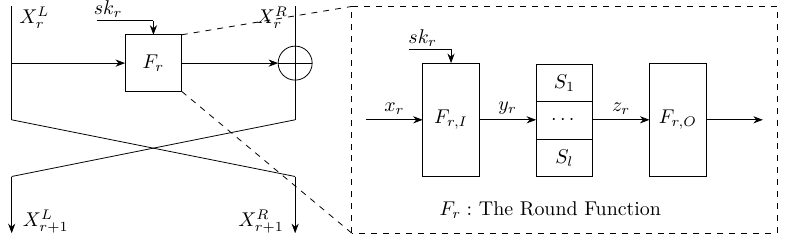
Figure 1: Generalized round of a Feistel